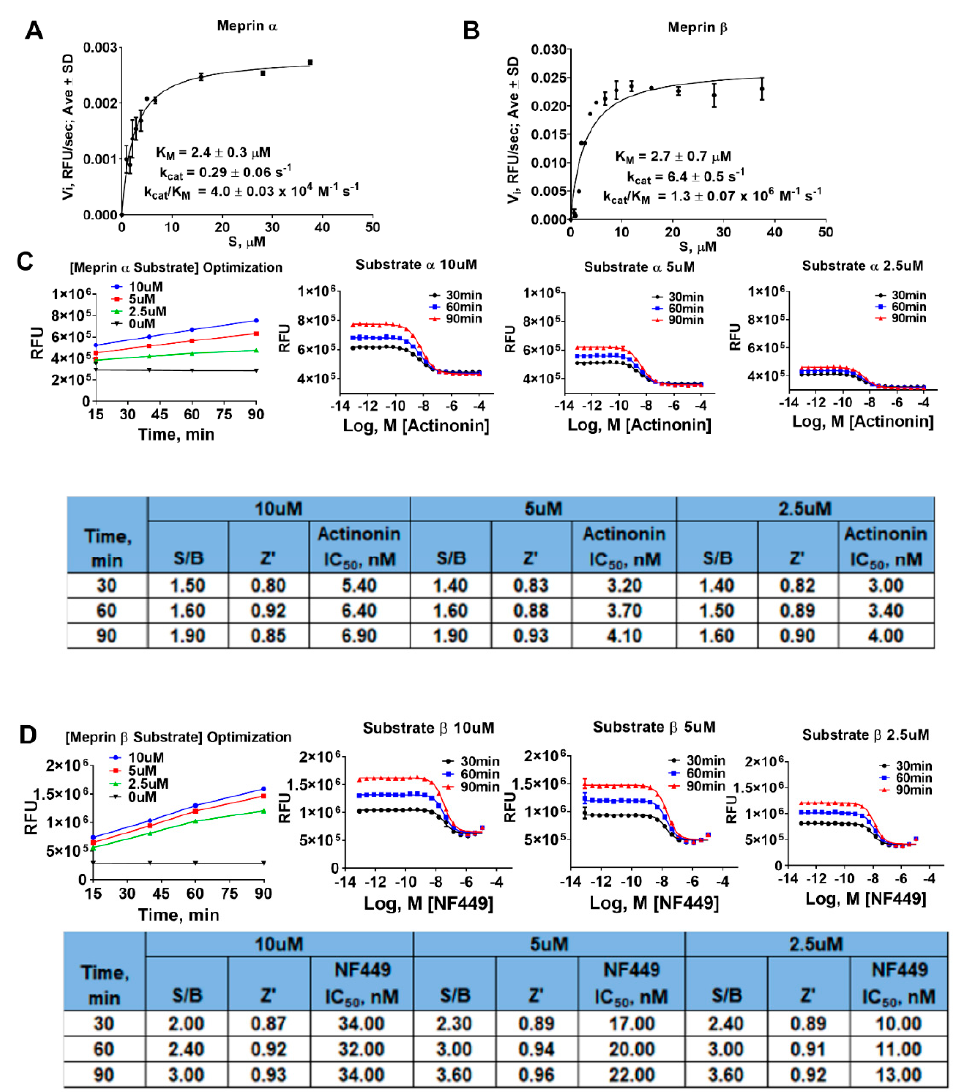
Figure 4. Substrate concentration optimization experiments in 1536 wpf. Results of kinetic studies of ( A ) meprin α and ( B ) meprin β hydrolysis of respective substrates. ( C ) Meprin α 1536 wpf assay optimization study. ( D ) Meprin β 1536 wpf assay optimization study. Experiments repeated twice, n = 4.